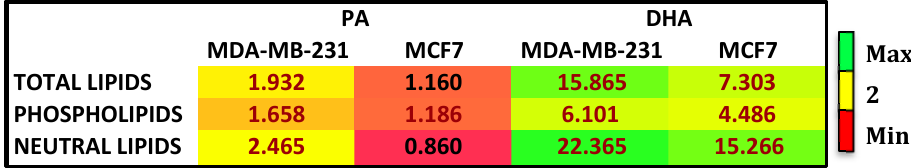
Figure 1. Enrichment heat map of palmitic acid (PA) and docosahexaenoic acid (DHA) in total lipids, phospholipids, and neutral lipids isolated from breast cancer MDA ‐ MB ‐ 231 and MCF7 cells after treatment with PA or DHA (50 μ M) for 72 h expressed as fold changes over control cells.